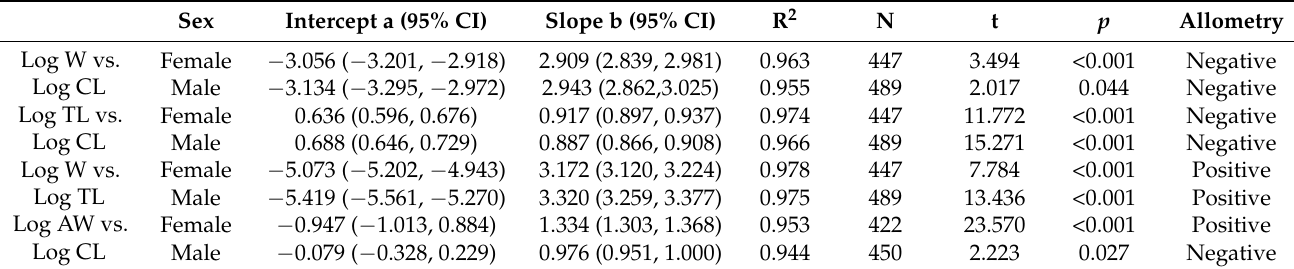
Figure 6. Morphometric relationships of male and female European lobster ( Homarus gammarus ) from the Eastern Adriatic Sea—( A ) CL vs. W; ( B ) TL vs. W; ( C ) CL vs. TL; and ( D ) CL vs. AW. CL, carapace length; W, weight; TL, total length; and AW, abdomen width. Table 2. Parameters of reduced major axis regressions between male and females and allometry tests of the European lobster ( Homarus gammarus